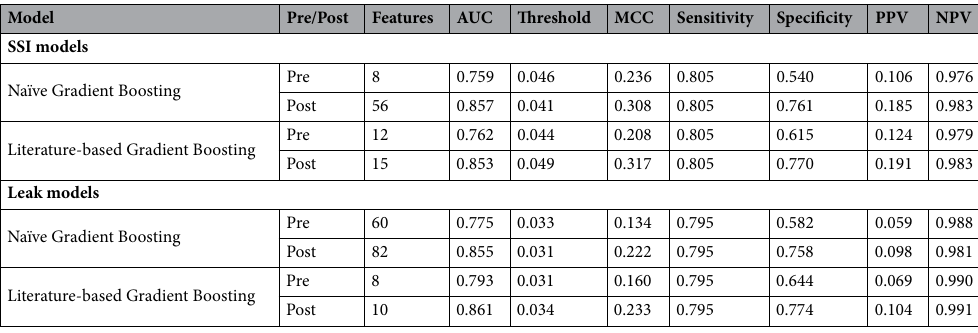
Table 1. Overview of Model Performances according to 80% sensitivity. Table depicts model performance of all pre- and postoperative SSI and leak models developed as part of this study. Naïve Gradient boosting refers to gradient boosting models where all pre-calculated features were considered, and the type and number of features were selected based on recursive feature elimination. Literature-based Gradient Boosting are gradient boosting models developed based on features reported in the literature combined with recursive feature elimination to reduce the number of features included in the models. Table contains AUC (area under the ROC curve) computed for the test set as well as specificity, PPV (positive predicted value), NPV (negative predicted value), and MCC (Matthew Correlation Coefficient) with respect to the probability threshold chosen to achieve 80%